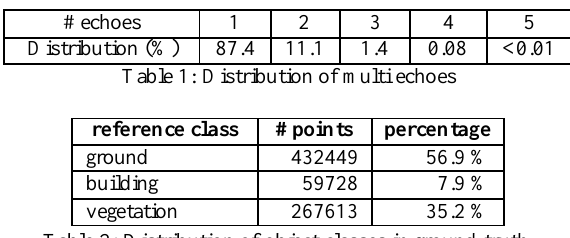
Table 2 : Distribution of object classes in ground truth.